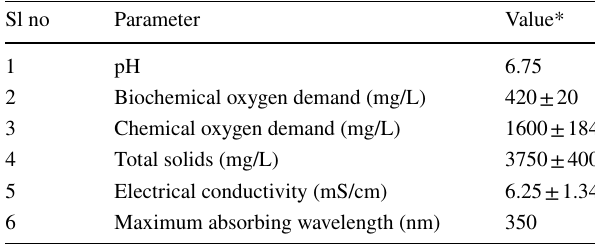
Table 1 Characteristics of textile dye wastewater